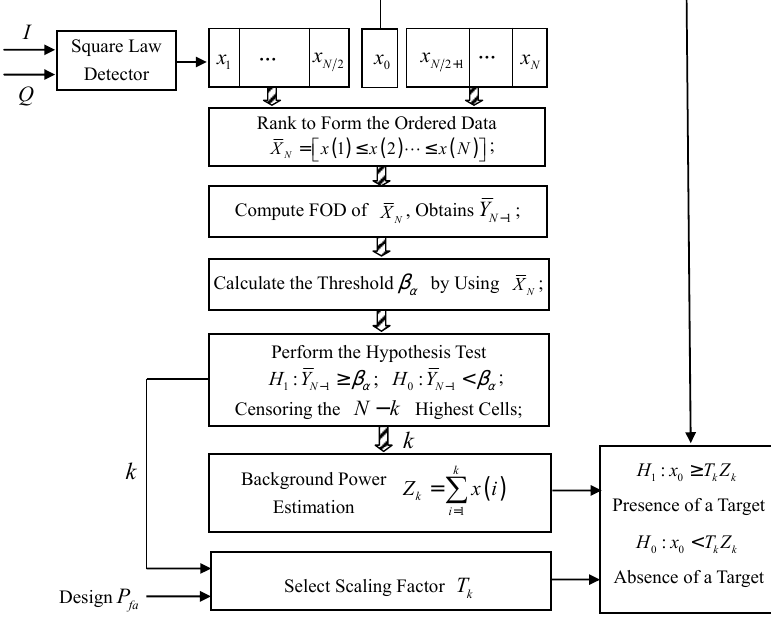
Figure 3. FOD-CFAR block